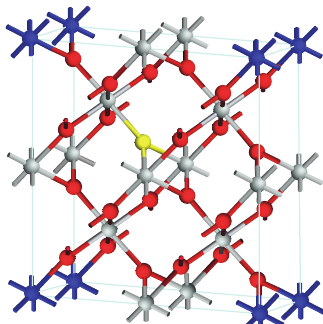
Figure 1: Supercell model for Ni + N-codoped rutile titanium dioxide in the present work (red ball represents the O atom; white ball represents the Ti atom; blue ball represents the Ni atom; yellow ball represents the N